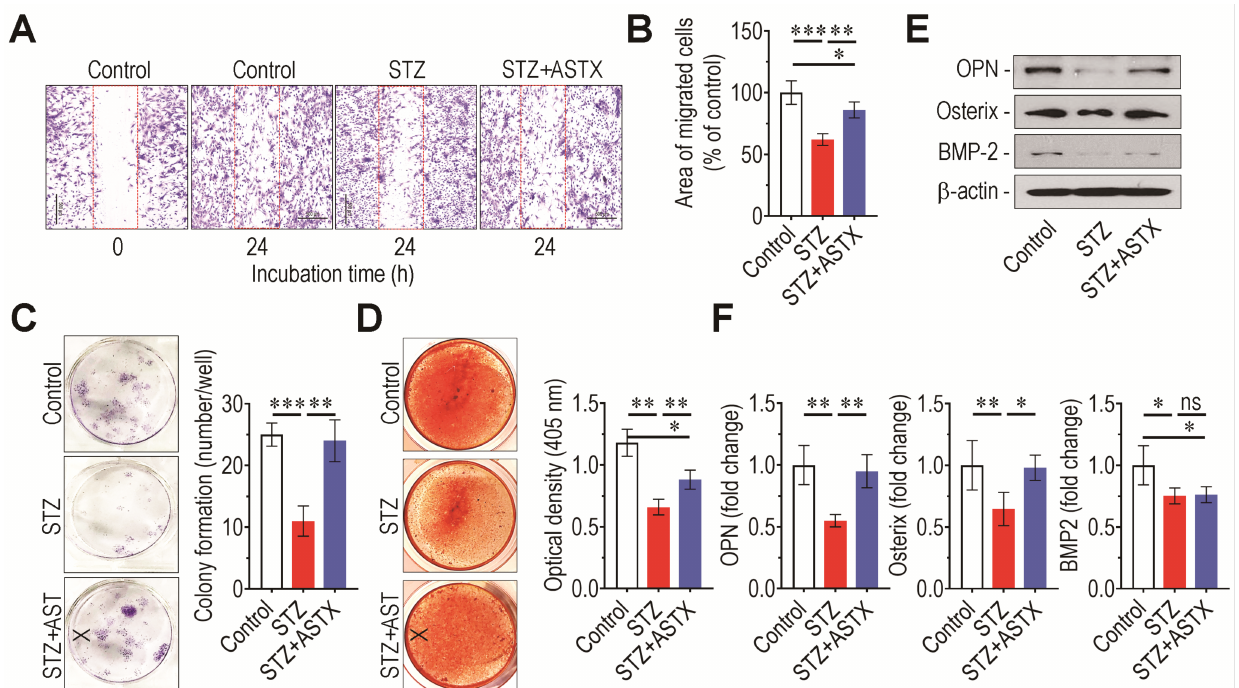
Figure 9. Oral supplementation with ASTX restores ex vivo migration, colony formation, and osteogenic potentials of BMSCs derived from STZ-injected mice. BMSCs derived from mouse groups were cultured on 12-well culture plates in growth medium, and wound areas were created by scraping cells. ( A ) After 24 h of incubation, wound areas were photographed (Bar = 500 µ m), and ( B ) the area covered by migrated cells was calculated as a percentage of the control ( n = 5/group). ( C ) Colonies formed by BMSCs that had been incubated in growth medium for 14 days were photographed, and colony numbers were counted under a light microscope ( n = 5/group). BMSCs derived from the mouse groups were also incubated in DAG-supplemented osteogenic medium. ( D ) After 21 days of incubation, cells were stained with Alizarin Red S, and the red dye-specific optical density of cells was determined using a microplate reader ( n = 5/group). ( E ) Protein levels of osteogenic markers in these cells were analyzed by immunoblot assay five days after incubation. ( F ) Band intensities specific to OPN, osterix, and BMP2 were calculated using ImageJ software ( n = 5/group). * p < 0.05, ** p < 0.01, and *** p < 0.001 by unpaired Student’s t